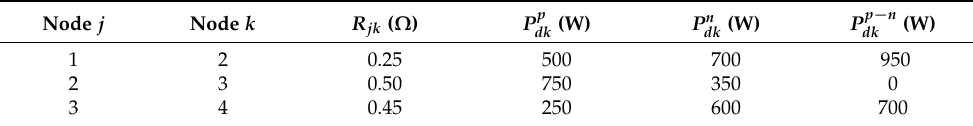
Table 1. Branch and load parameters for the four-bus